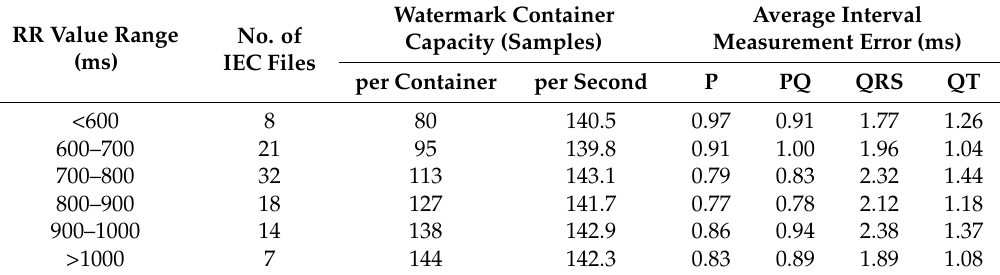
Table 5. Influence of the host ECG heart rate to the watermark capacity and the average interval measurement error.